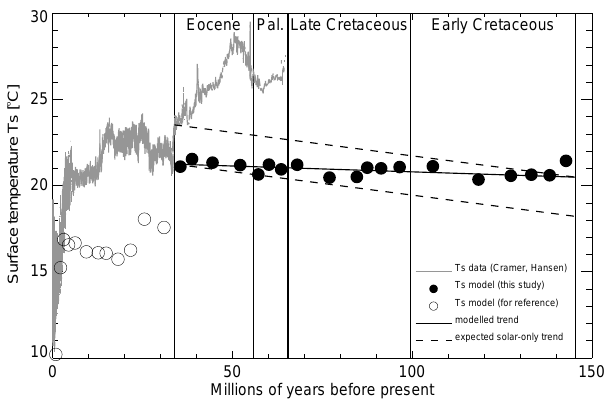
Figure 5. The global MAT for each Stage of the CPE at 4 × CO 2 (black filled circles) plotted over a surface temperature record pro- duced by applying the methodologies of Hansen et al. (2013) to the Cramer et al. (2009) δ 18 O benthic data, and applying a 10-point run- ning average (grey line). The open circles show model results for the Oligocene and Neogene, with lower CO 2 , which are not dis- cussed in this paper but are provided for reference. The modelled trend (ignoring the outlying Berriasian stage) is shown as a solid line, and the expected trend assuming solar forcing only is shown as a pair of dashed lines which start/end at the beginning/end of the modelled